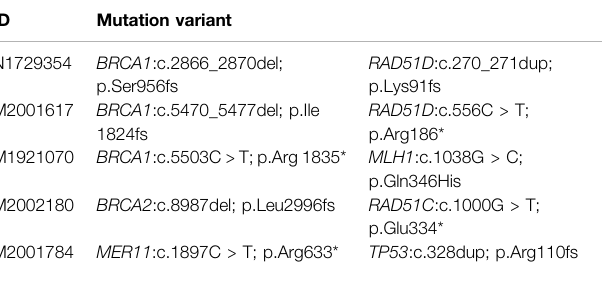
TABLE 2 | Patients Harboring Multiple